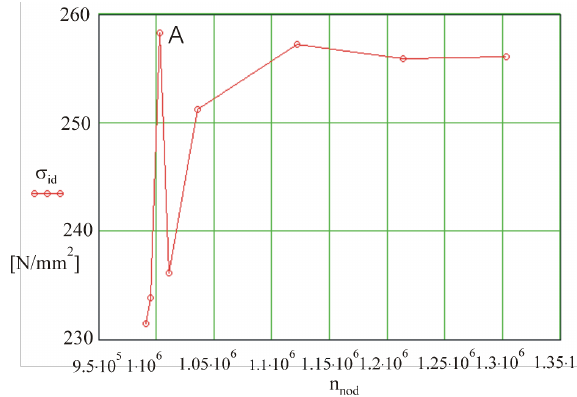
Figure 14: Convergence curve to check the stress σ id in the highly stressed area indicated in Figure 13.